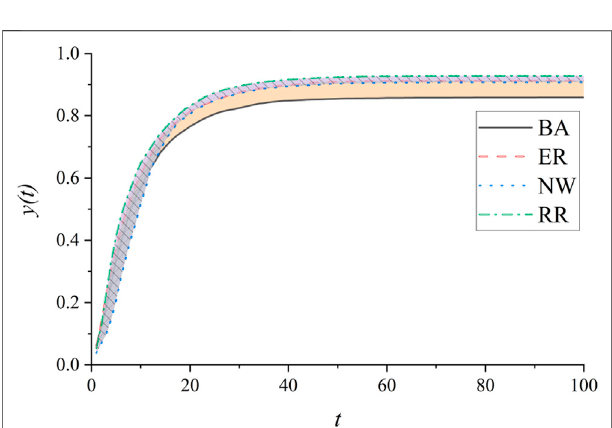
FIGURE 2 | Performance of UAV swarm under different attack intensities and topological structures. The vertical axis represents the performance of the UAV swarm, and the horizontal axisrepresentsthe logarithm ofattack intensity.